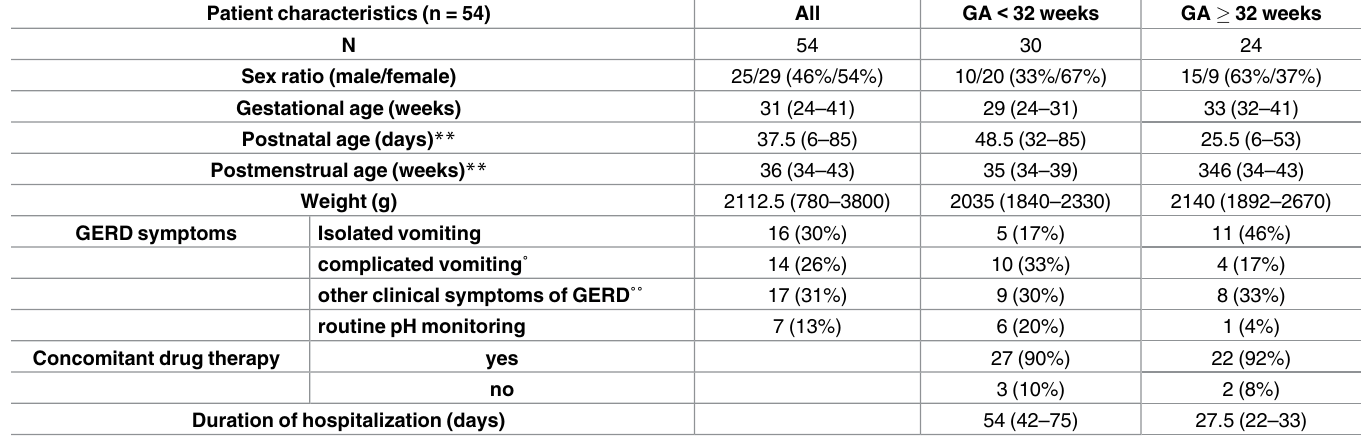
Table 1. Characteristics of neonates included in the